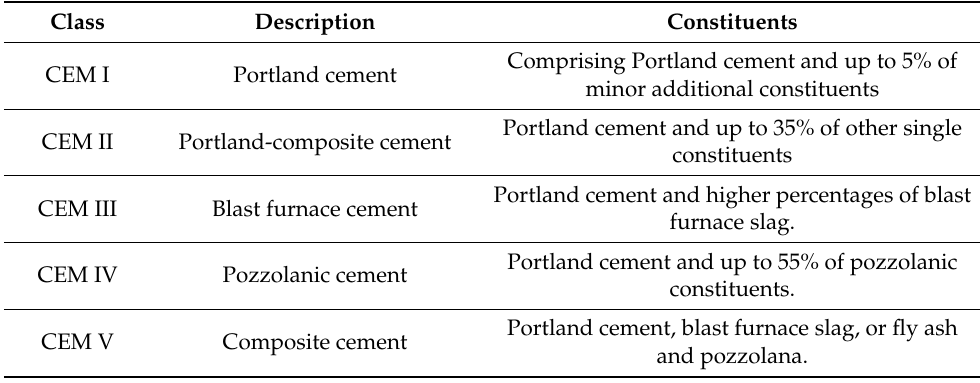
Table 4. Types of cement